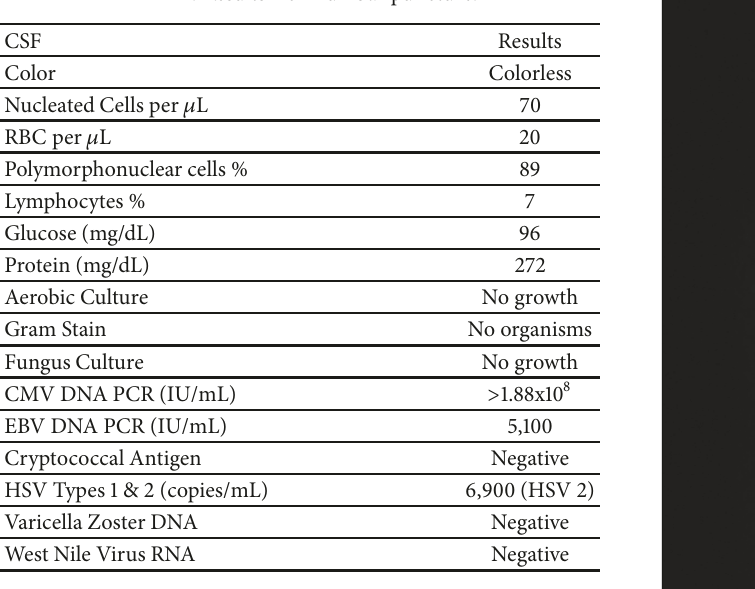
Table 1: Results from lumbar puncture.